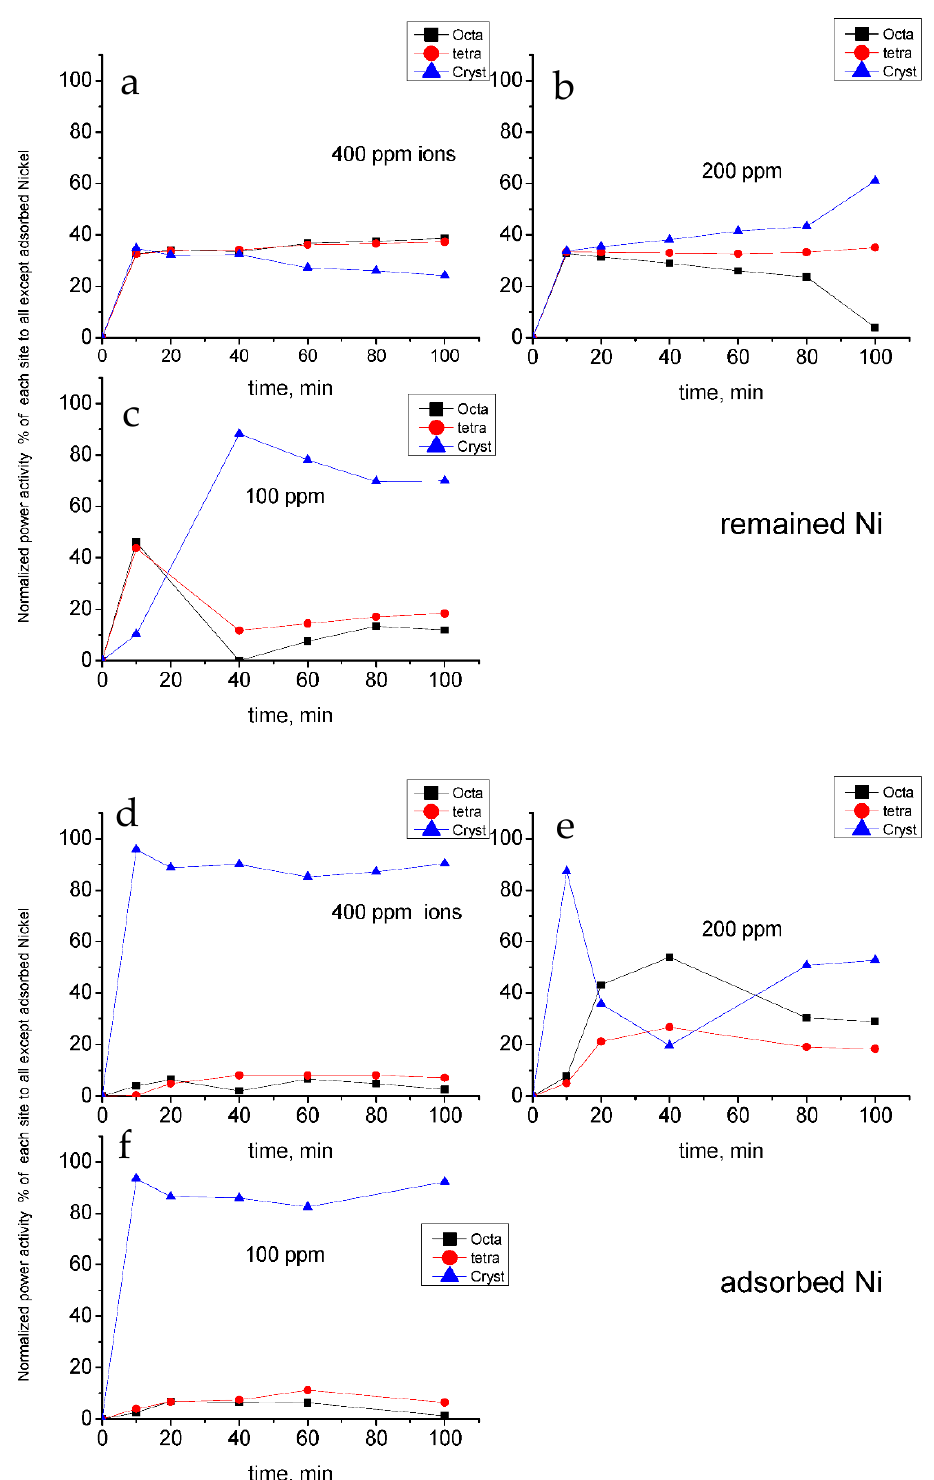
Figure 15. Effect of remained and adsorbed nickel ions on the power activity map: ( a ) 400 ppm remained; ( b ) 200 ppm remained; ( c ) 100 ppm remained; ( d ) 400 ppm adsorbed; ( e ) 200 ppm adsorbed; ( f ) 100 ppm adsorbed.